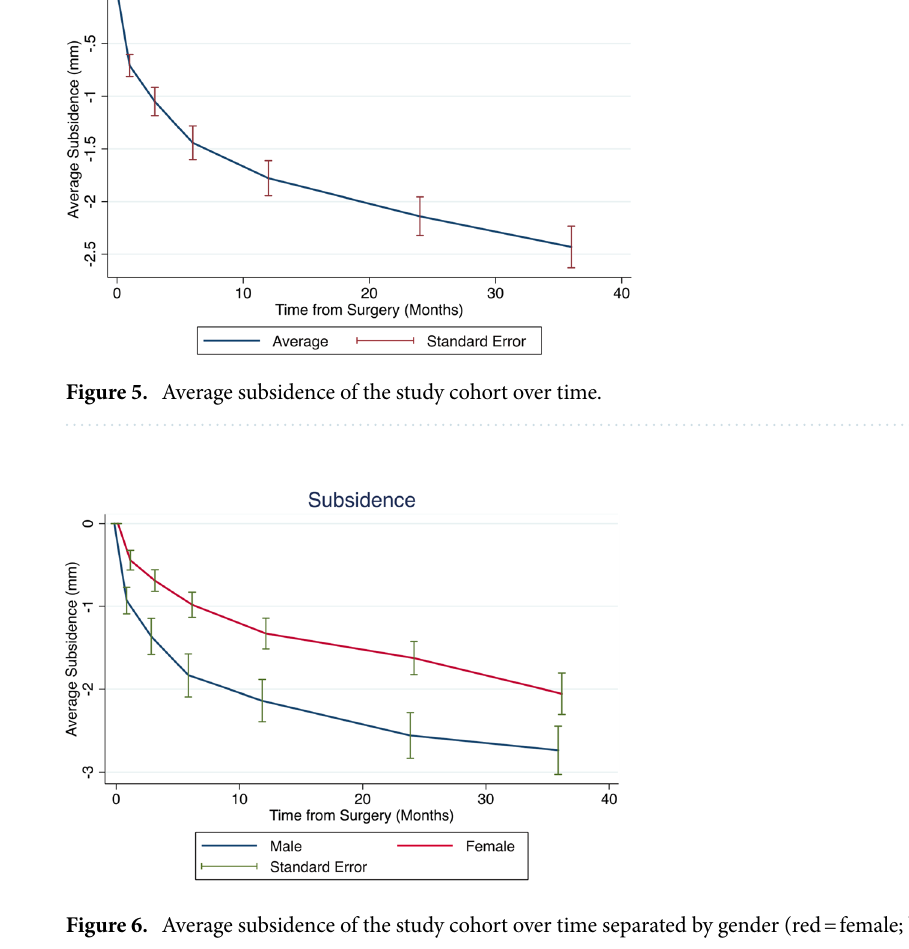
Figure 6. Average subsidence of the study cohort over time separated by gender (red = female; blue = male).